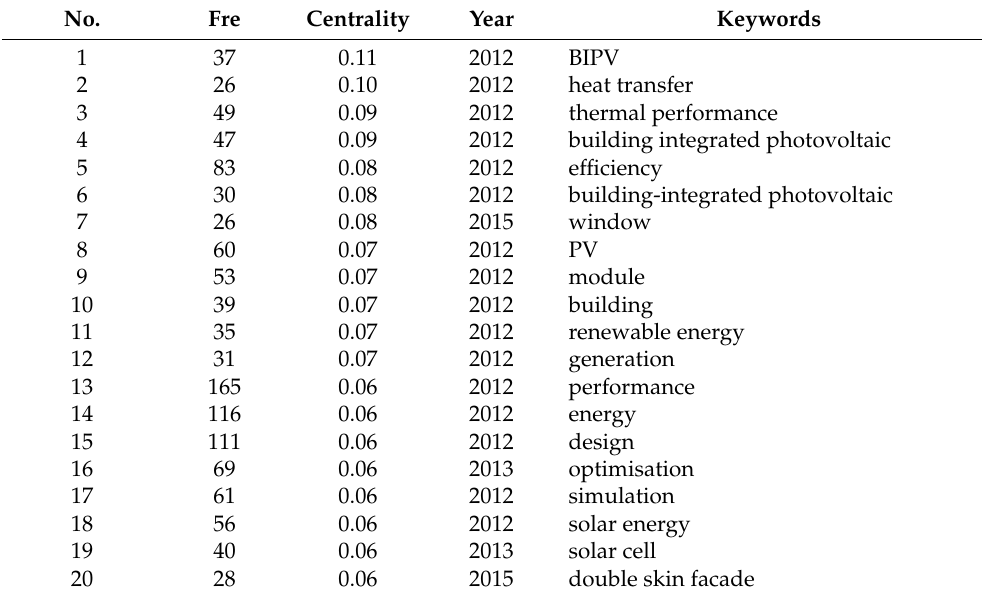
Table 8. The co ‐ occurrence centrality of the top 20 keywords.